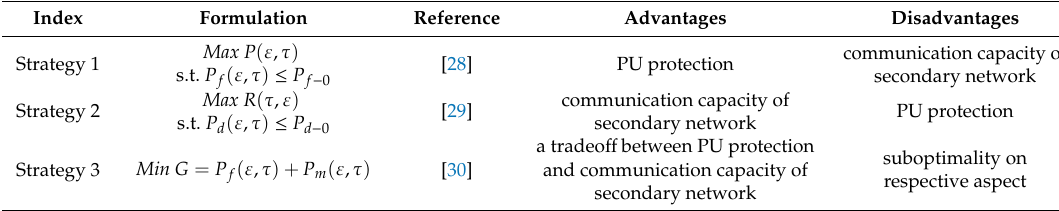
Table 1. Comparisons of three classical sensing